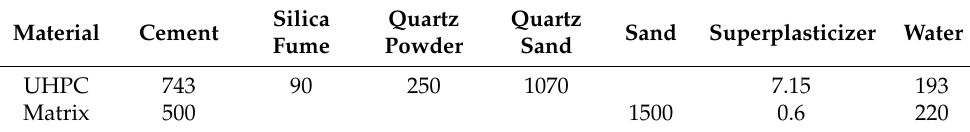
Table 3. Basic mix proportion of materials (kg/m 3 ).